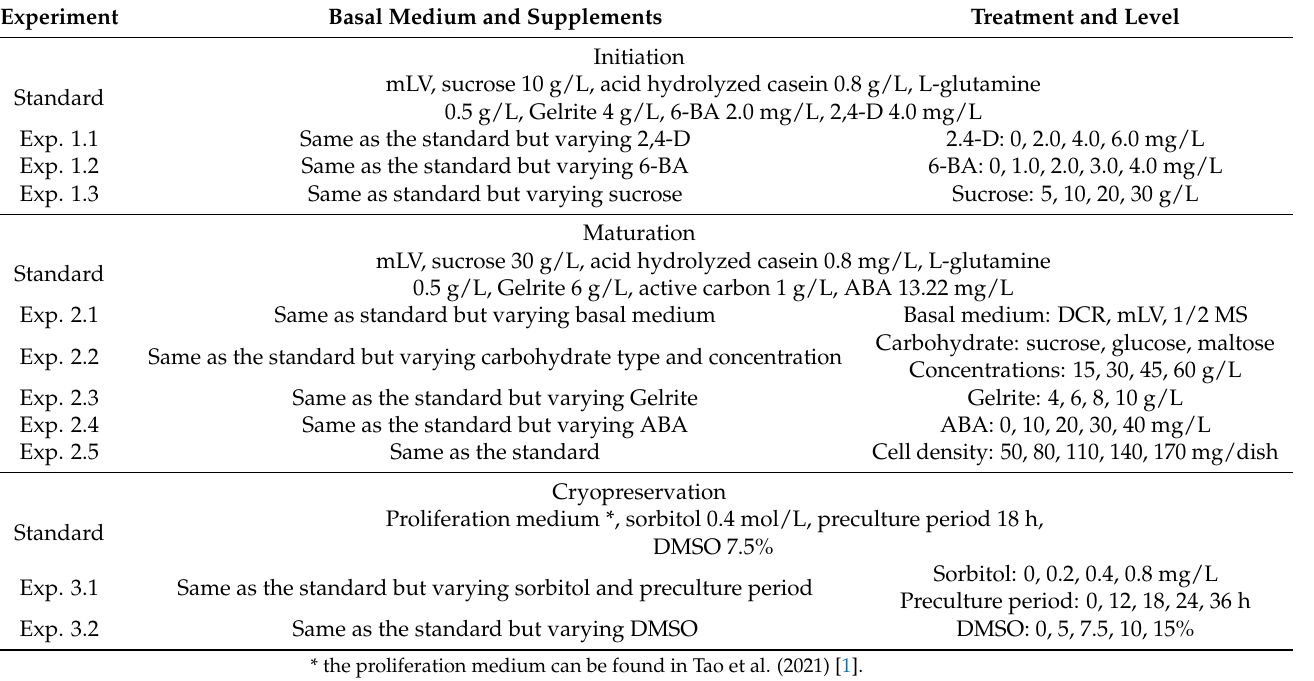
Table 1. Basal medium, medium supplements and treatments by